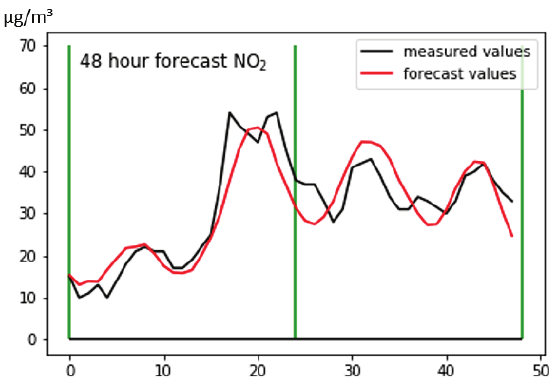
Figure 3: Outline of the system architecture.